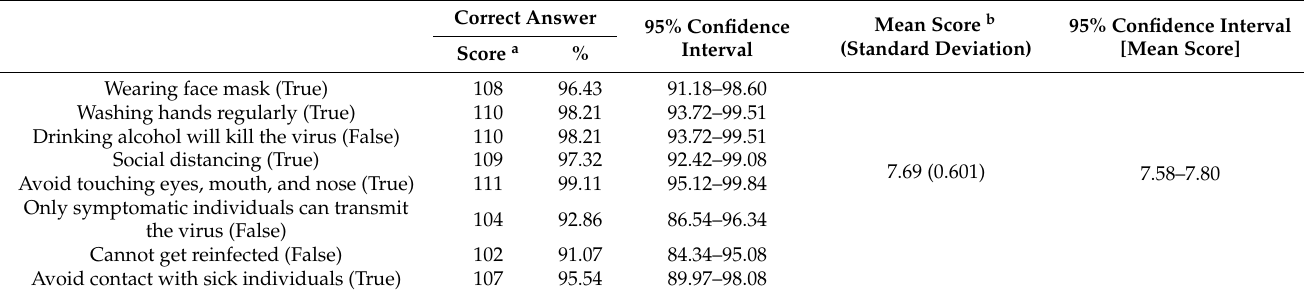
Table 3 unveils the answers for the protective measures against COVID-19. Overall, students had thorough knowledge about the protective measures against COVID-19. ‘Avoid touching your eyes, mouth, and nose’ received the highest score of 99.11%, whereas ‘Once you have had the disease you cannot get reinfected’ received the lowest score of 91.07%. The average mean score for the protective measures was 7.69 ± 0.601 (range, 0–8) with an average knowledge level of 96.13% ([7.69/8] × 100). Table 3. Knowledge about the protective measures against COVID-19.